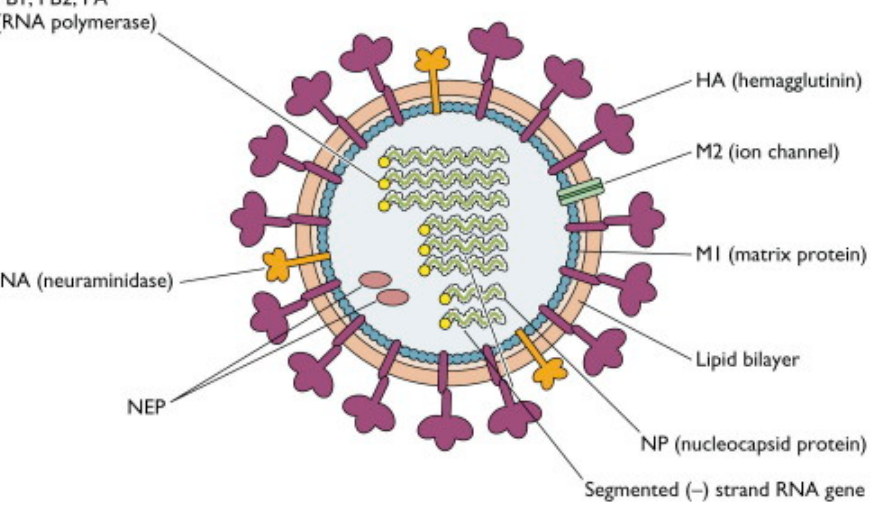
Figure 1. Structure of influenza A virus showing the two major surface glycoproteins (hemagglutinin (HA) and neuraminidase (NA)), the nucleocapsid and polymerase proteins (NP, PB1, PB2, and PA), the matrix proteins (M1 and M2), the non-structural proteins (nuclear export protein (NEP)), lipid bilayer and segmented negative-strand RNA genes [48].